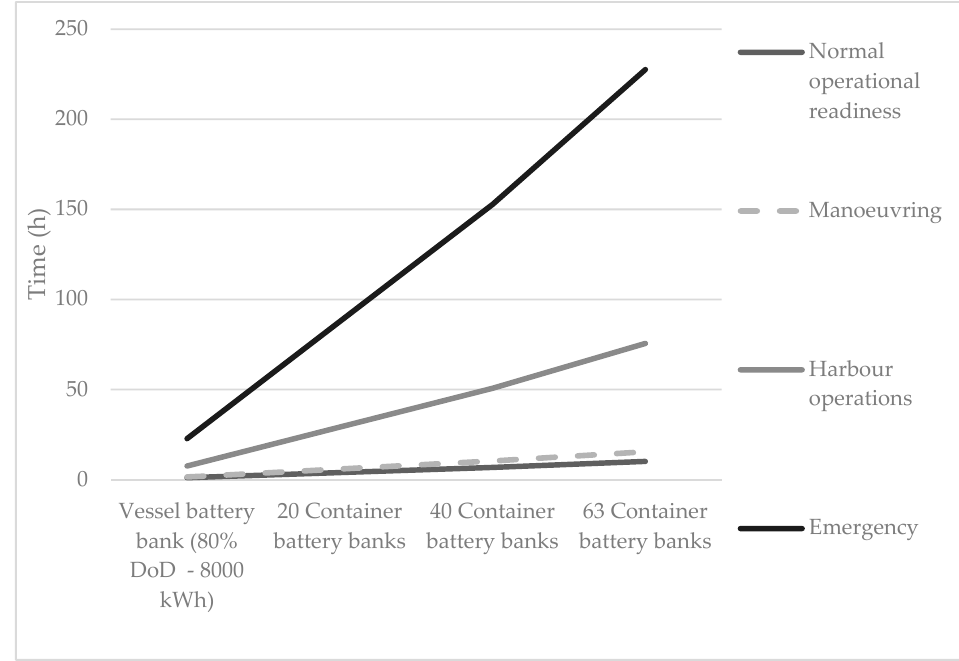
Figure 10. Operation time of the vessel as a function of the number of container battery banks.